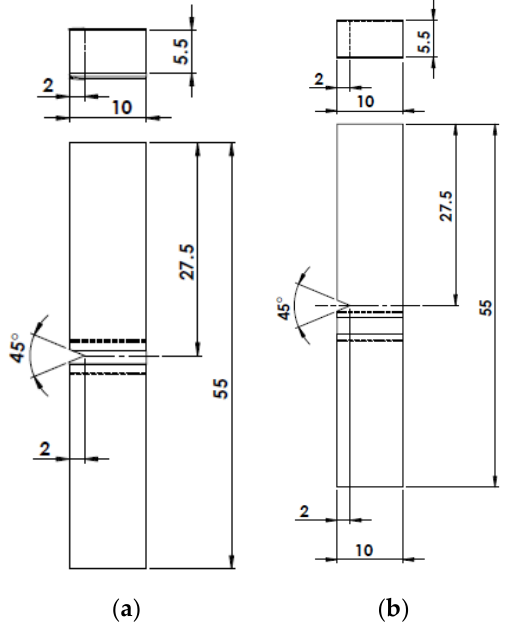
Figure 4. Test specimens for the impact test (units in mm). The notch is in the weld zone ( a ) and in the heat affected zone HAZ ( b ).